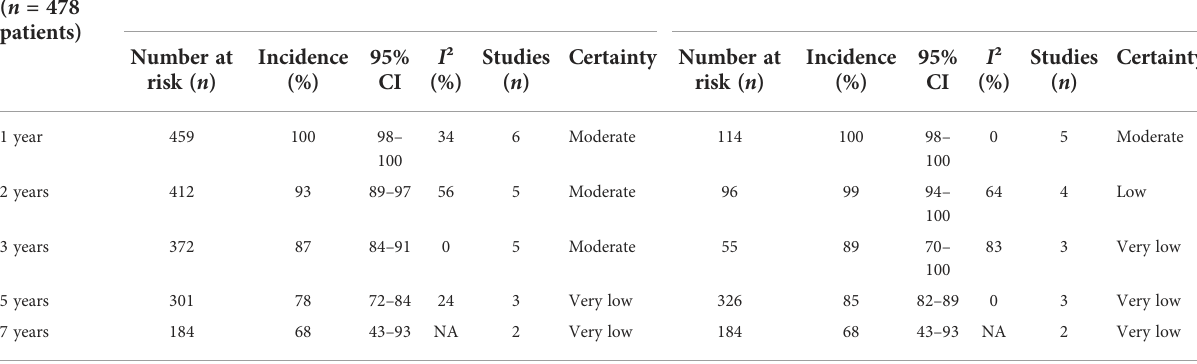
TABLE 3 Local control and overall survival incidence and error estimates as indicated by the contemporary literature, with certainty assessed for each outcome per the GRADE criteria. All studies ( n =